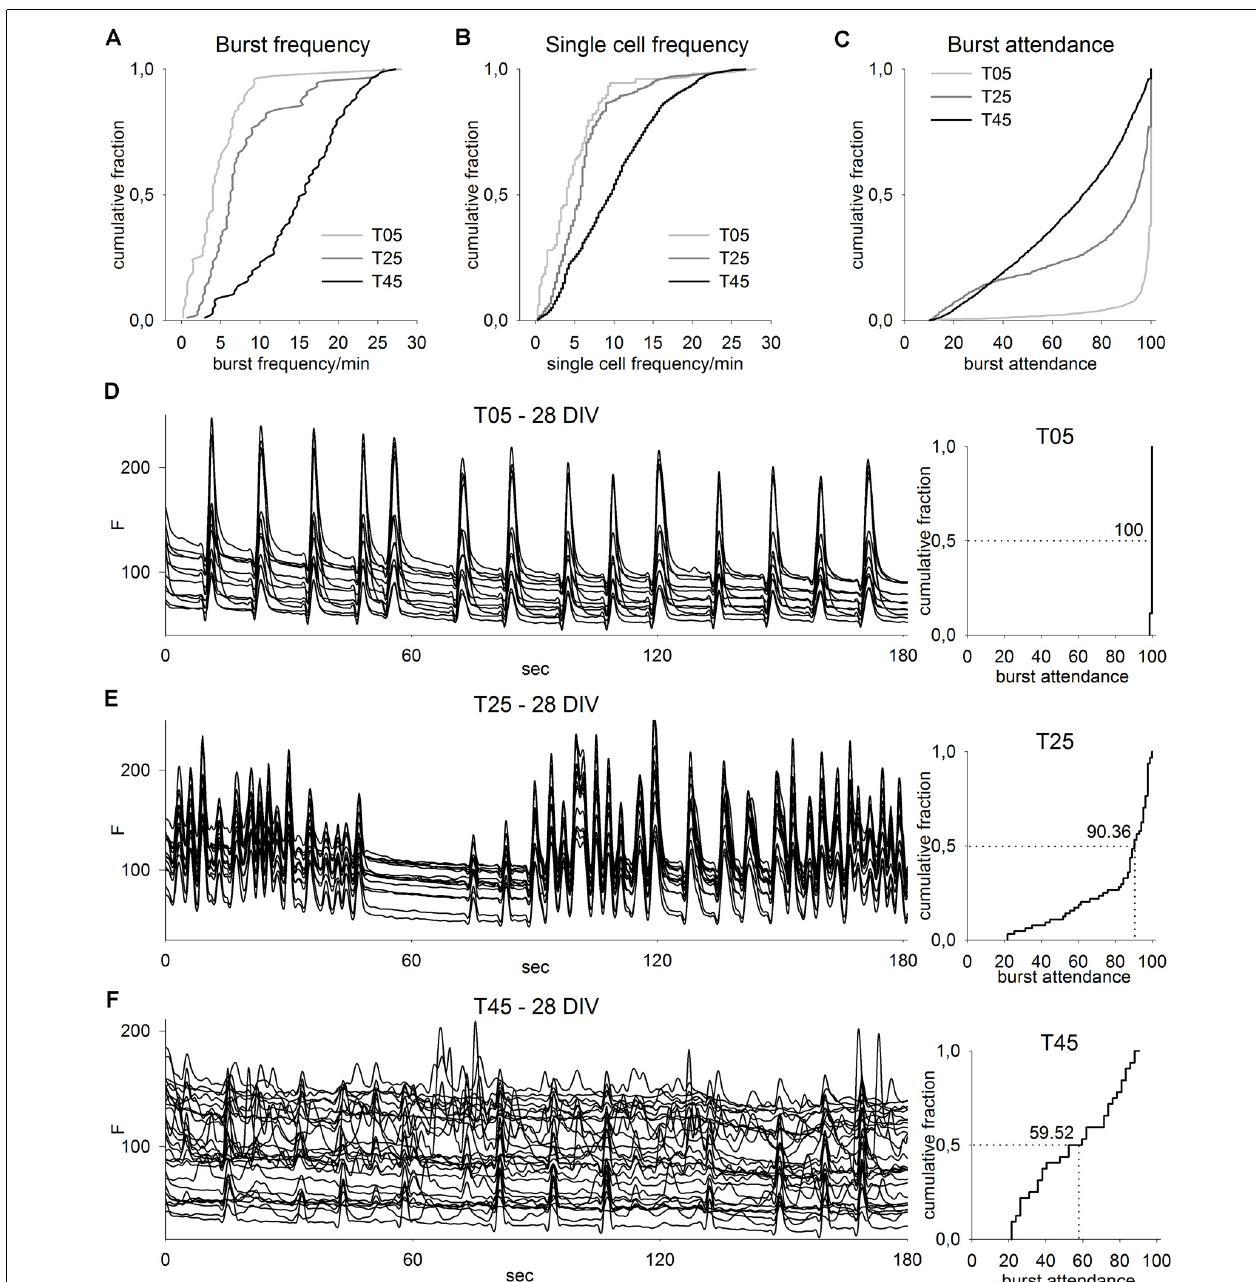
FIGURE 7 | Calcium imaging analysis of different network types. (A–C) CDF graphs show the imaging results of T05, T25, and T45 network recordings. With increasing MGE-IN content, network burst frequency (A) and single-cell burst frequency (B) increased but burst attendance (C) decreased (T05: n = 82, T25: n = 90, T45: n = 87; numbers correspond to the sum of data from 10 recorded fields in each of three cultures between ages 14 and 28 DIV from each of three independent experiments). (D–F) Imaging traces from exemplary fields of T05 (D) , T25 (E) , and T45 (F) networks (left, 28 DIV) show for clarity only 3 min of the recording time and a reduced number of traces. The corresponding CDF plots of burst attendance (right) are calculated from the background-corrected dF/F 0 values (see “Materials and Methods” section) and include the data of the entire 4 min record and all active neurons within the fields. The median of the burst attendance (number of neurons participating in a burst) is shown in each